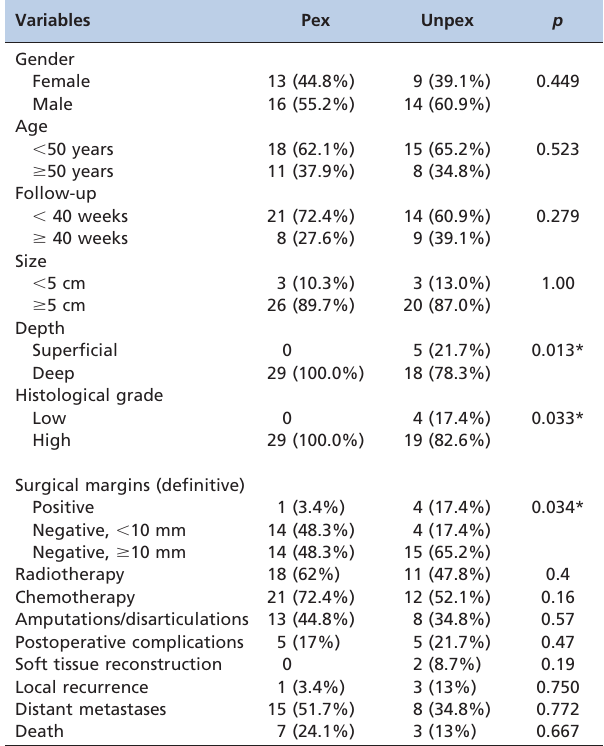
Table 3 - Comparison between planned and unplanned